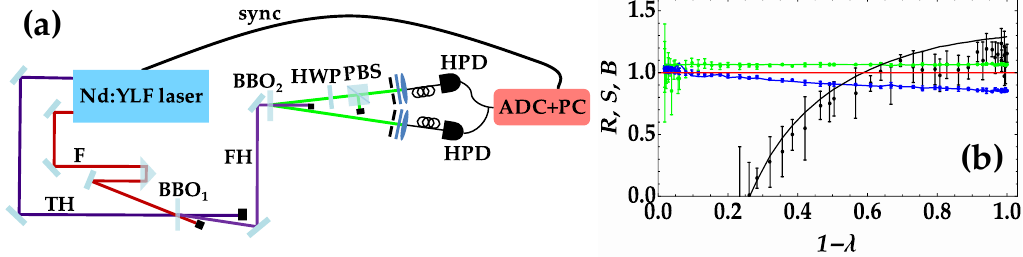
Figure 1. ( a ): Sketch of the experimental setup. See Section 4 for details. ( b ): Noise reduction factor (blue dots), S parameter (green dots) and B parameter (black dots) as functions of 1 − λ . The theoretical expectations are shown as lines with the same color choice. The red line at R = 1 represents the boundary condition, with (cid:104) m (cid:105) = 2.1, µ = 100 and η =